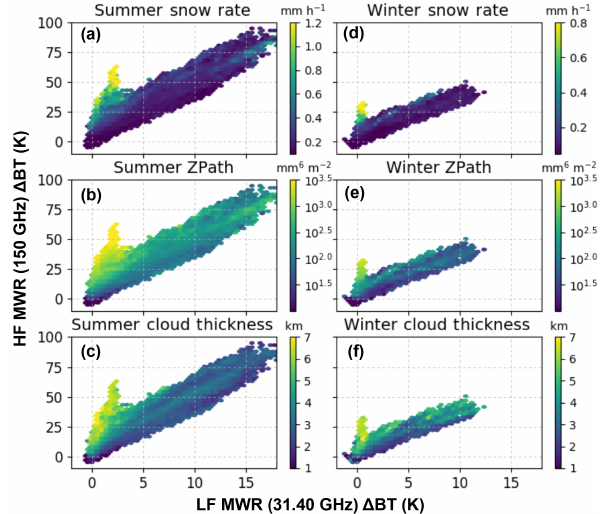
Figure 7. Values of MMCR calculated snow rate, Z PATH , and cloud thickness are calculated for all the precipitation events and plotted with the associated HF and LF MWR observations. The left pan- els (a, b, c) depict these characteristics for the summer months and the right panels (d, e, f) for the winter months. Regardless of sea- son, the IC precipitation has a higher instantaneous snow rate than the CLW cases. Additionally, the Z PATH values for the IC snow cases are much higher than the CLW cases. The IC snow tends to be associated with deeper clouds than the CLW snow.